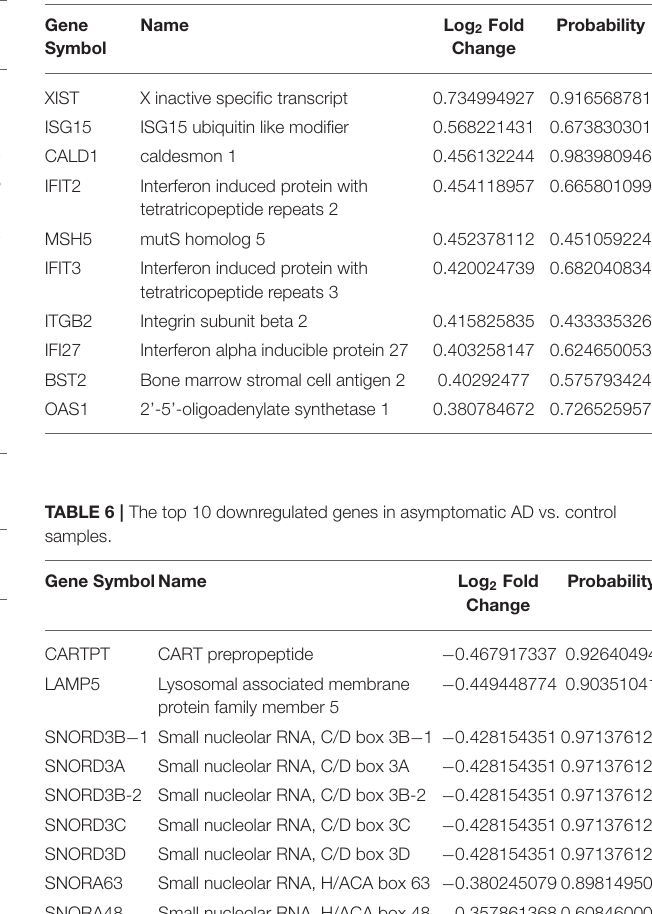
TABLE 2 | The top 10 upregulated genes in AD vs. asymptomatic samples.